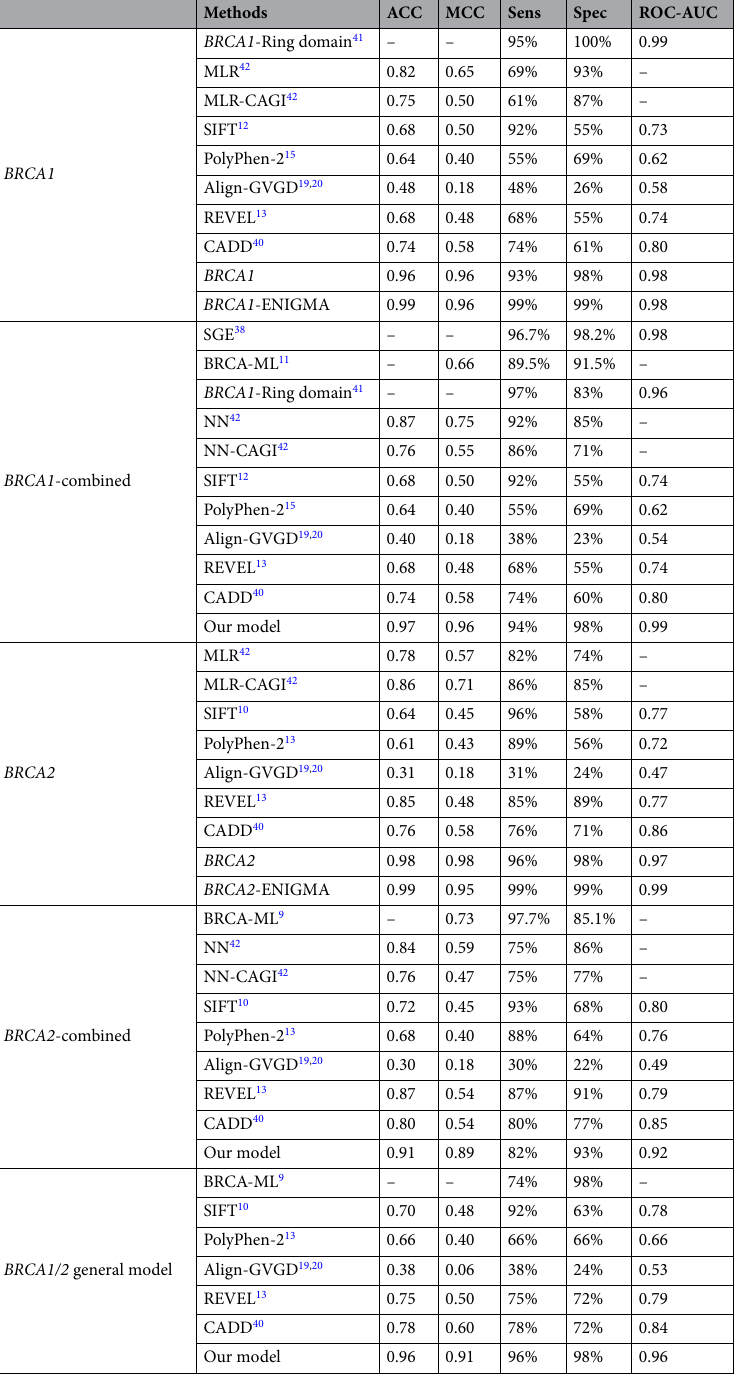
Table 2. Comparative Performance on cross-validation between BRCA1/2 classification models and other available